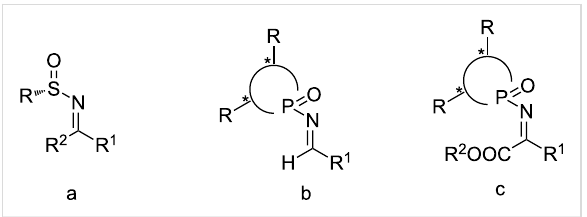
Figure 1: Typical sulfinyl (a), phosphonyl aldimines (b) and phos- phinyl imino esters